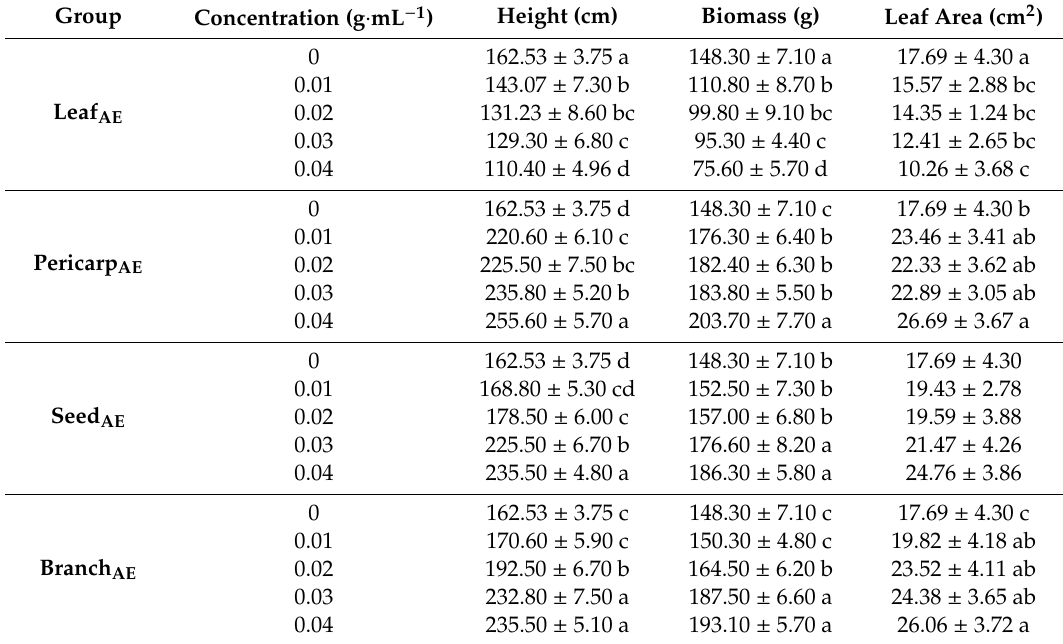
Table 2. E ff ects of aqueous extract of litter from di ff erent anatomical parts of C. migao on seedling growth.